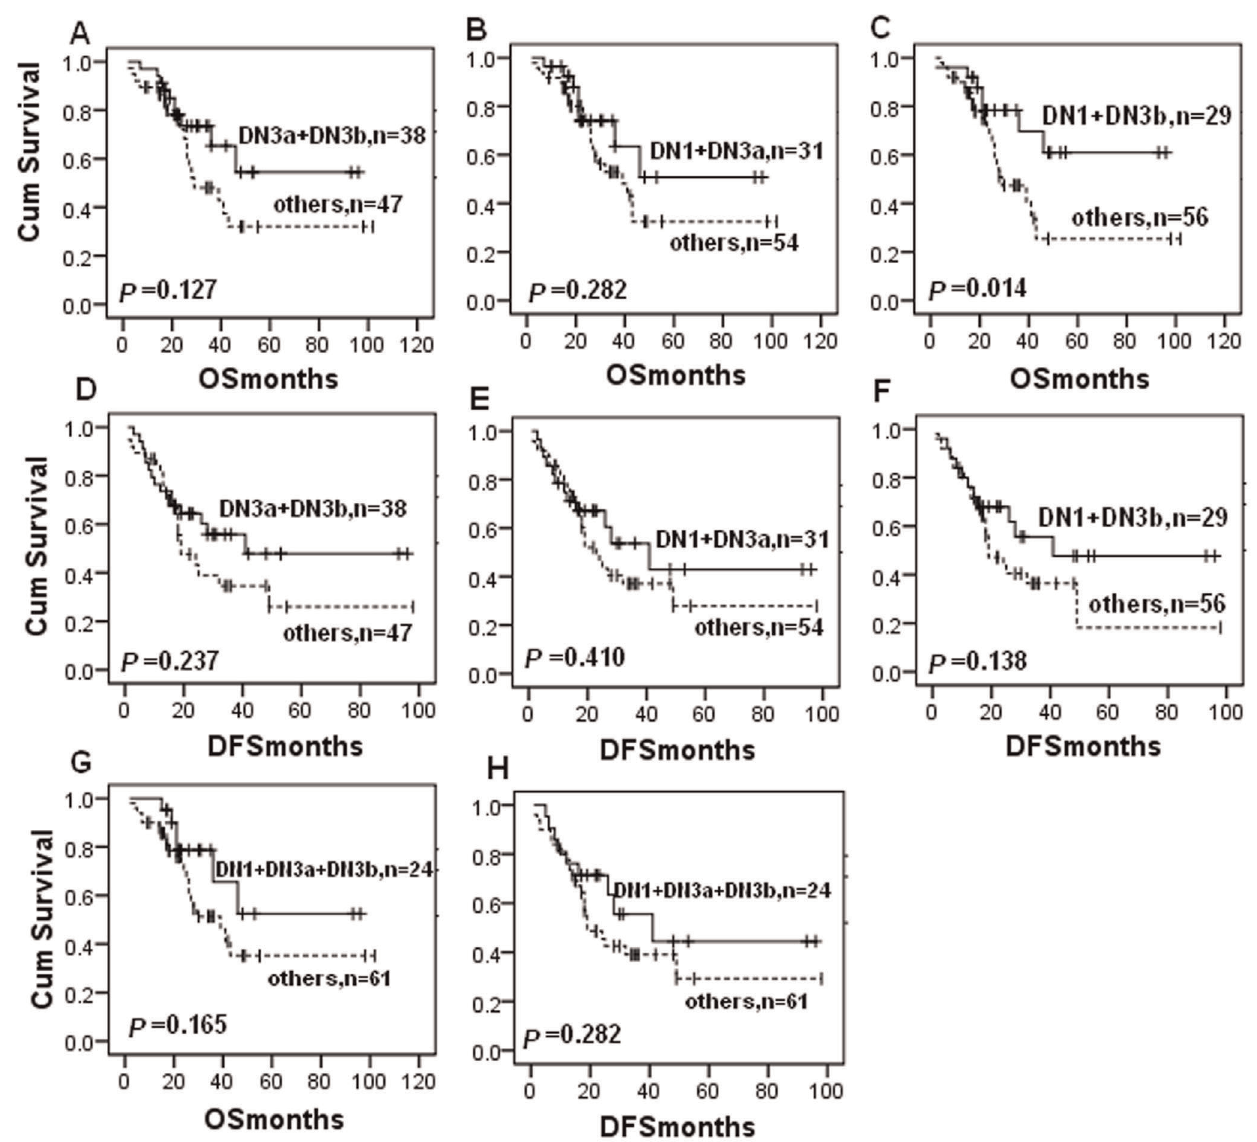
Figure 4. Kaplan-Meier estimates of patients with ovarian cancer stratified by co-expression of DNMTs. Survival curves show that co- expression of DNMT1 and DNMT3b was significantly associated with improved overall survival compared to negative samples ( P =0.014, Fig. 3E). P - value obtained from the log-rank test.